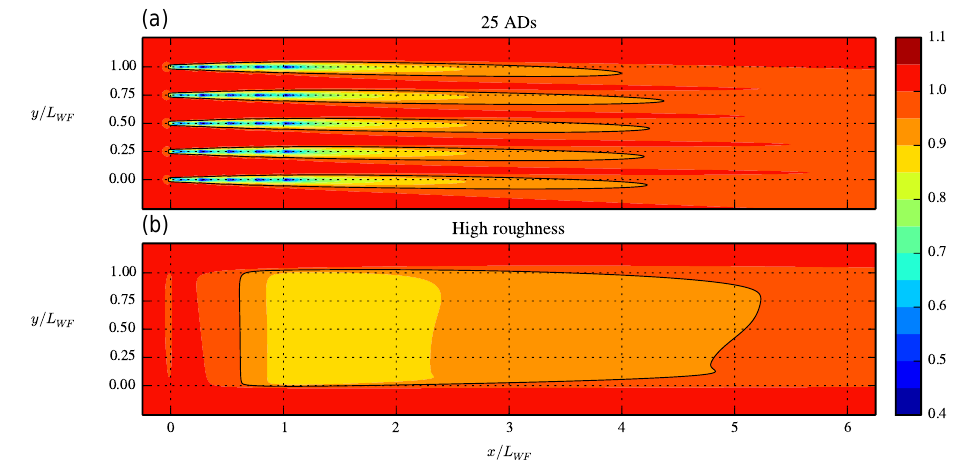
Figure 4. Stream-wise velocity at hub height, normalized by the free stream. (a) Wind farm modeled with 25ADs. (b) Wind farm modeled as a high roughness. Contour line represents 95% recovered